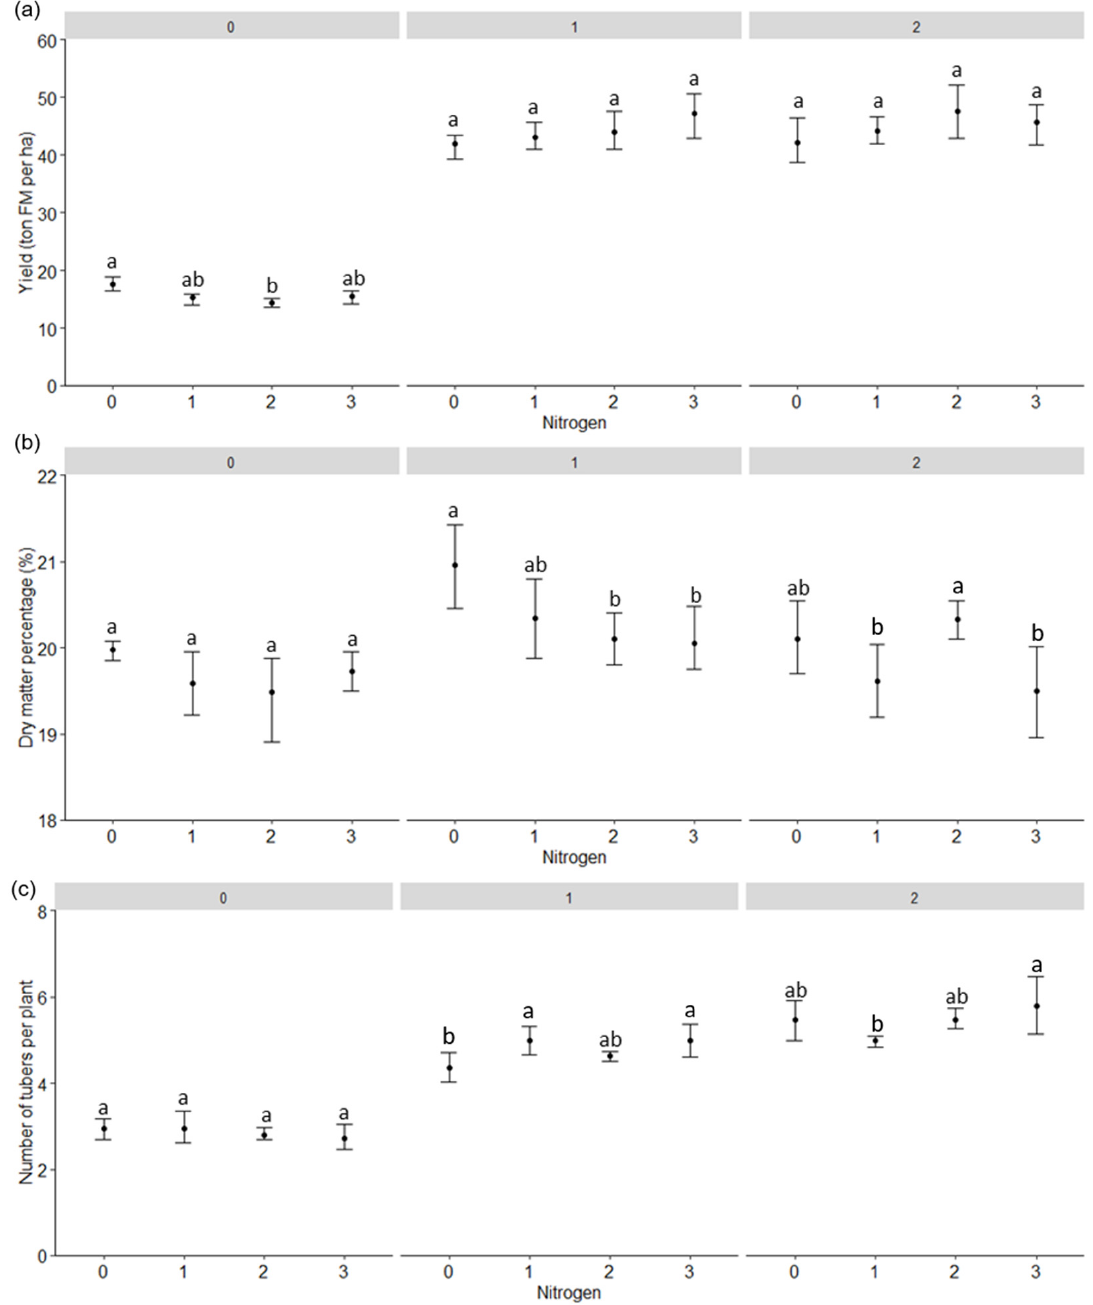
Figure 1. The interaction effect of nitrogen (N) fertiliser (four levels) and irrigation (three levels) on ( a ) potato fresh matter yield (FM), ( b ) dry matter content (DM%), and ( c ) number of tubers per plant in the 2017 experiment. The three irrigation treatments were (0) no-irrigation, (1) farmer’s irrigation and (2) full irrigation, at the top of each figure. The four nitrogen treatments were (0) zero N fertiliser (N0), (1) 184 kg N ha − 1 (N1), (2) 225 kg N ha − 1 (N2), (3) 267 kg N ha − 1 (N3). The point indicates the mean of the observed values (four replications), and an error bar indicates the 95% confidence interval of the means of four replications. No shared letters between treatments refers to a statistically significant difference ( p < 0.05).